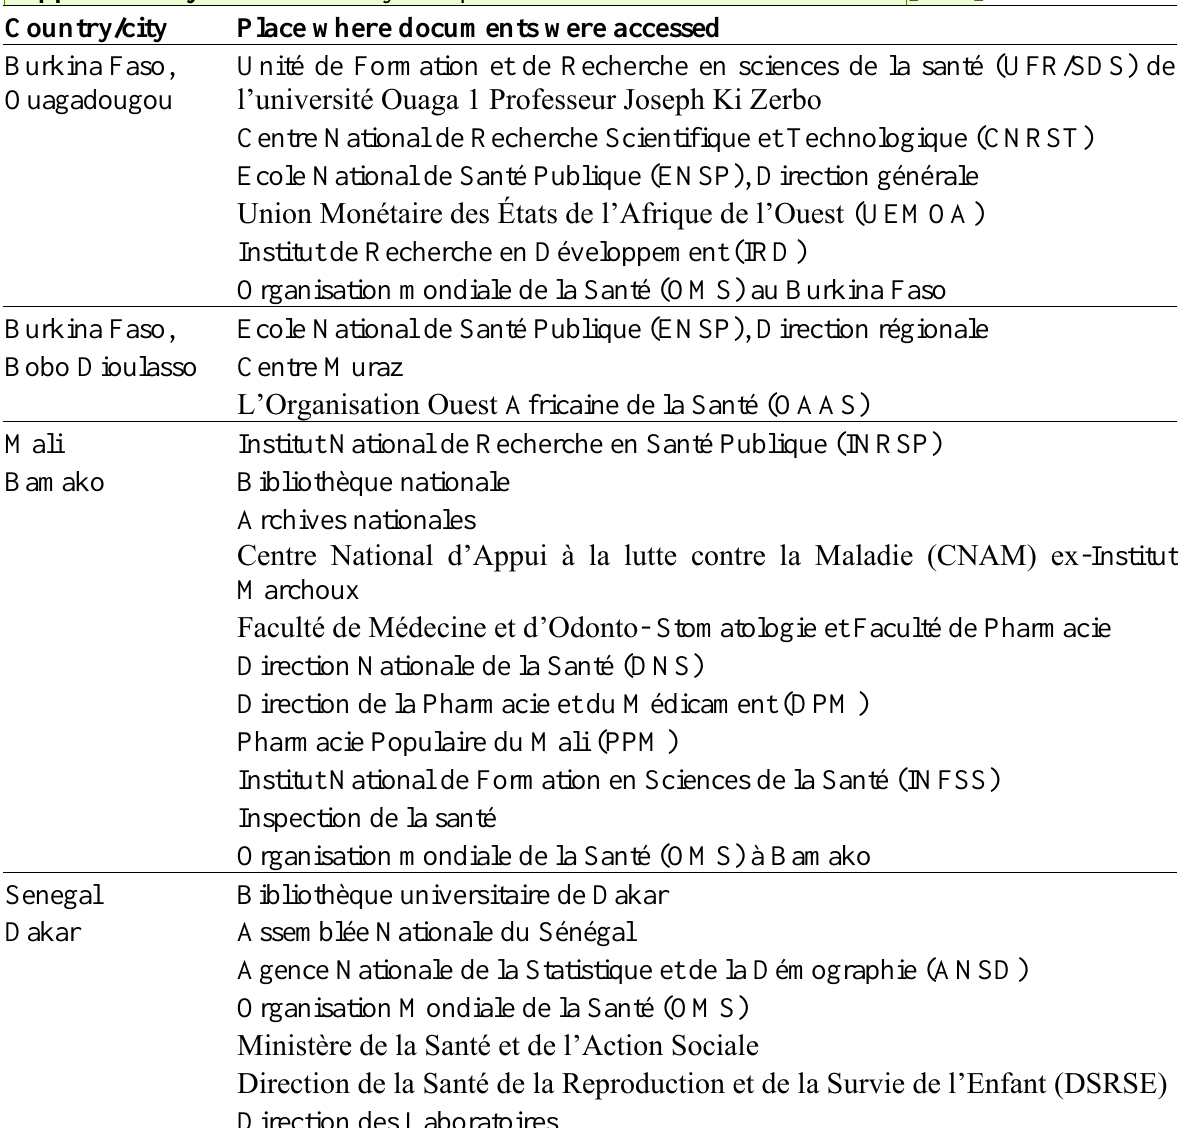
Supplementary TABLE 1: Physical places where literature was accessed [BR1]